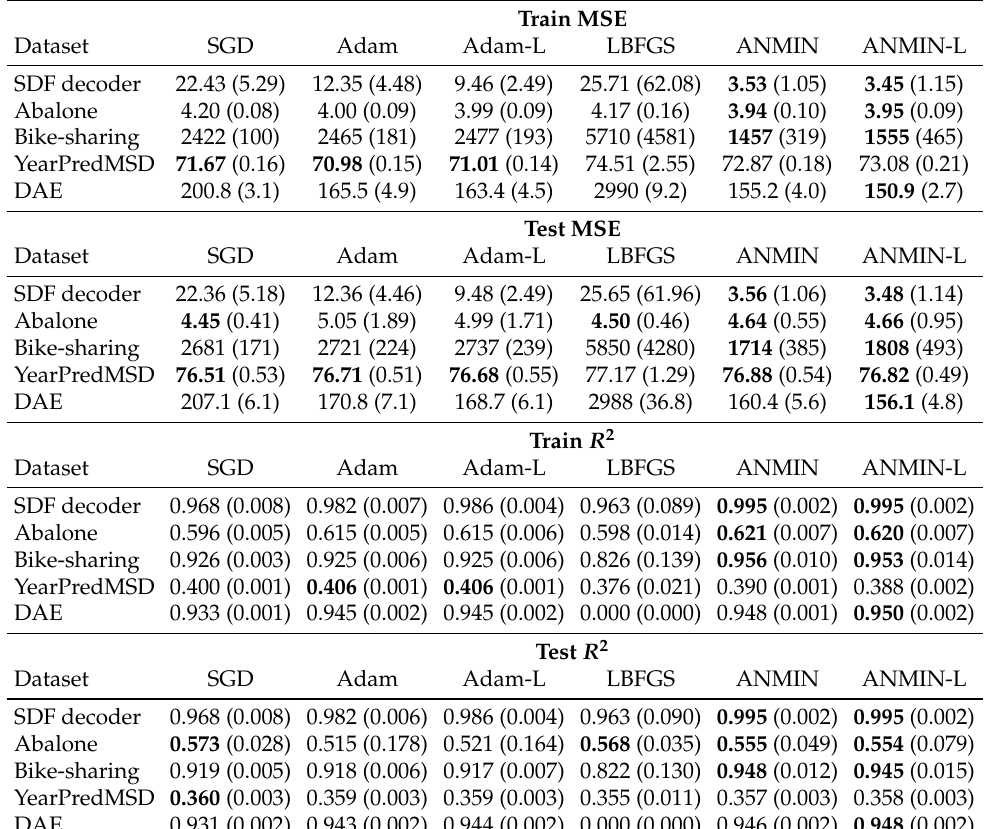
Table 3. Real data experiments. Average final train and test MSE values and R 2 (all with standard deviation (std) on five datasets. All results are obtained from 100 random splits into 80% train and 20% test. The best results and the ones not significantly worse ( p > 0.01) are shown in